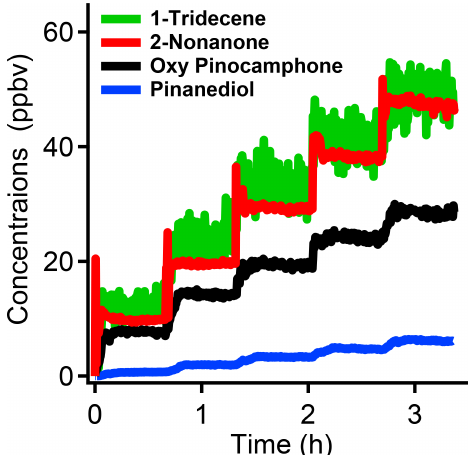
Figure 1. The gas phase concentrations of n -tridecane, 1-tridecene, 2-nonanone, 2-Nonanol, oxy-pinocamphone, and pinanediol in the chamber measured by TDGC/MS. Compared to the amount of organics injected into the chamber, n -tridecane, 1-tridecene, 2- nonanone, and 2-nonanol show almost no vapor wall loss. Oxy- pinocamphone and pinanediol show 43 and 86% loss, respectively.